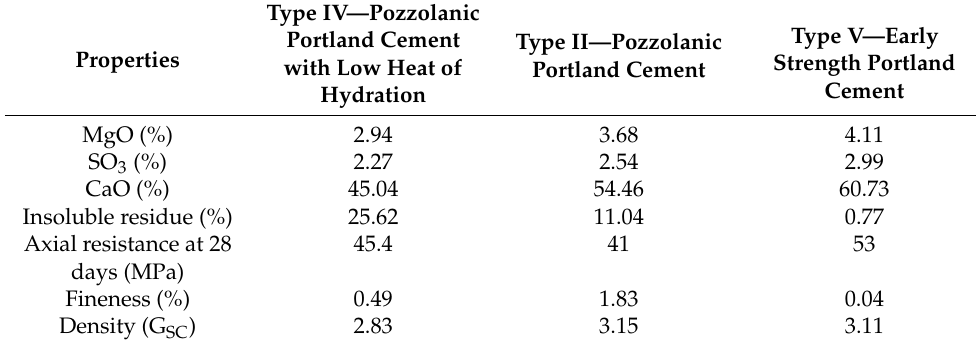
Table 3. Some physical and chemical properties of cements following the NBR 16697 [29].